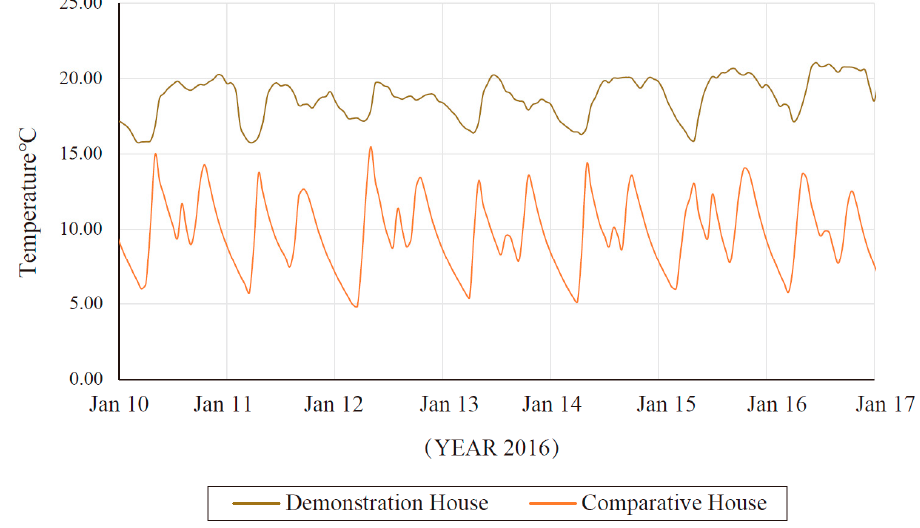
Figure 19. Temperature in the builidng.